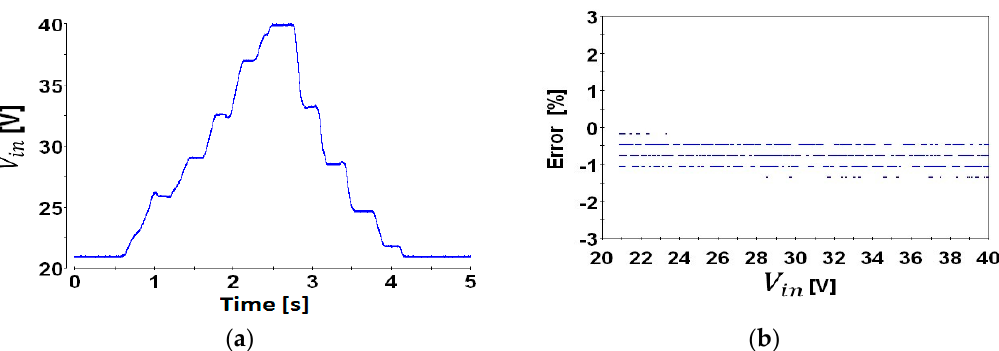
Figure 18. Experimental behavior of the buck-motor system after perturbations in V in when K S 3 = 40, K S 1 = K S 2 = 2, and N = 1: ( a ) variation of V in over time and ( b ) phase diagram of the error vs. V in .